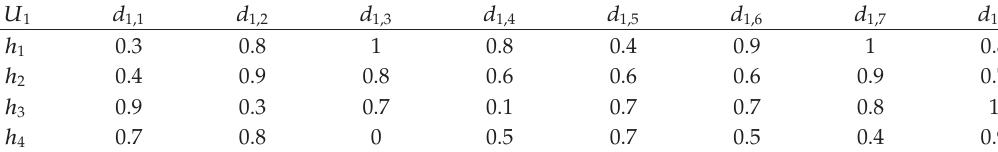
(cid:5) H,D (cid:6) .